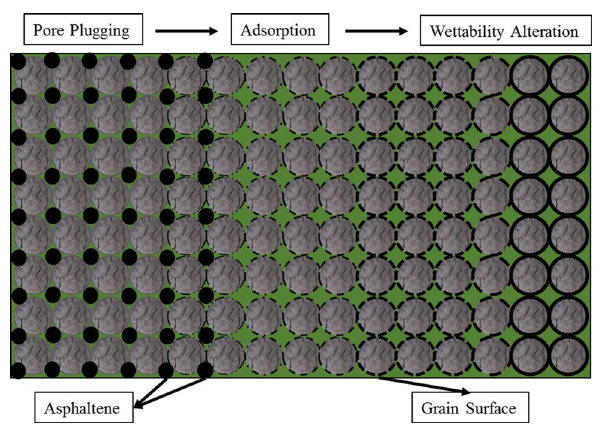
Fig. 12 Asphaltene impacts on oil